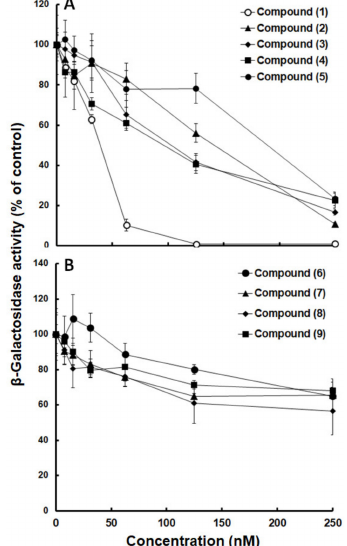
Figure 2. Dose response curves of 9 Medicines for Malaria Venture (MMV) Malaria Box compounds. Compounds 1–5 inhibit N. caninum proliferation with IC 50 values (inhibitory concentration of 50% of the solvent control value) below 200 nM ( A ), compounds 6–9 are less e ff ective ( B ). The inhibition of N. caninum tachyzoite proliferation was determined using a β -galactosidase reporter strain in the presence of a concentration series of compounds added prior to the infection of confluent human foreskin fibroblasts by tachyzoites. The mean values ± SE are indicated for